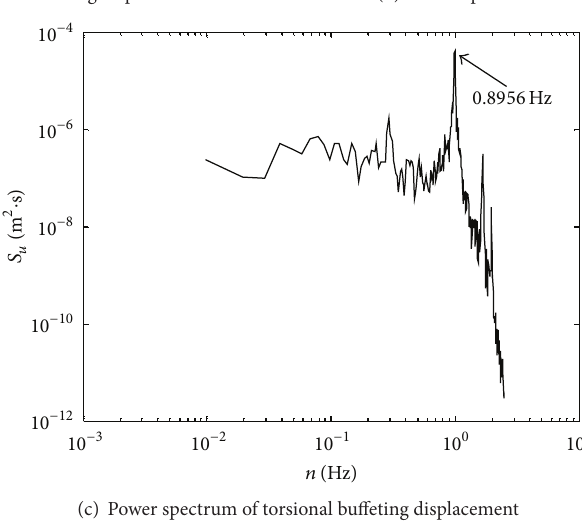
Figure 12: Power spectra of buffeting displacements in the middle of the bridge